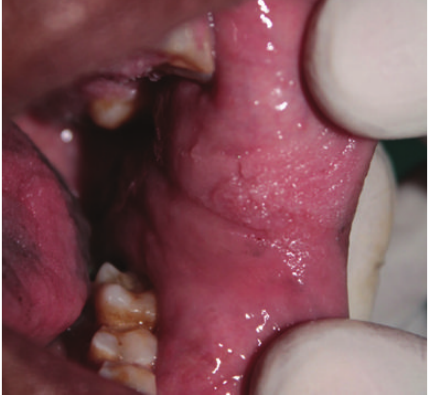
Figure 6: Papillary lesion at the left commissural area.